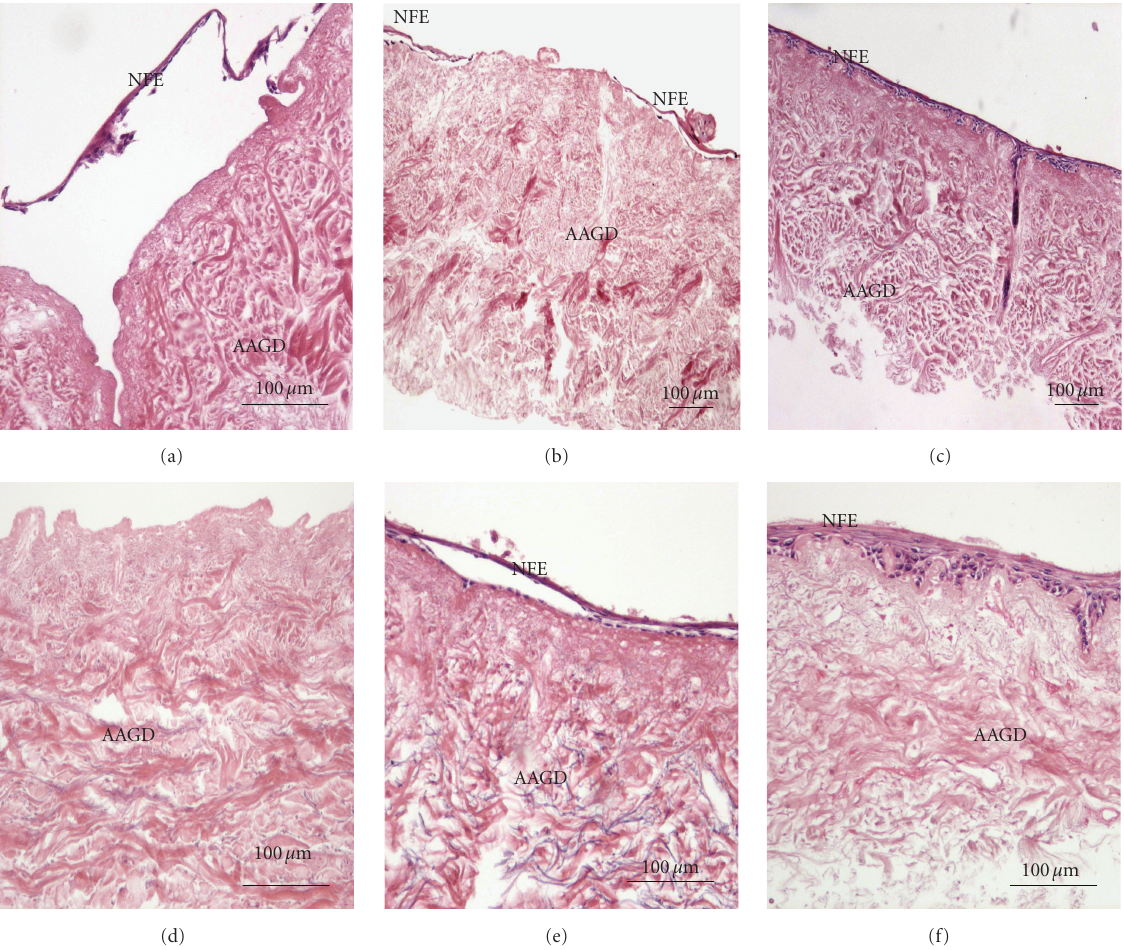
Figure 3: Histomorphological analysis of the dermis obtained by the three di ff erent techniques nebulized with keratinocytes. The sample refers to the 14th day ((a), (b), and (c)) and to the 21st day ((d), (e), and (f)), (a) and (d) Dispase II, (b) and (e) Trypsin, (c) and (f): the manual method. Nebulized cell adherence was observed only in the one prepared manually. Original magnification: 10x ((a), (d), (e) and (f)) 5x ((b) and (c)). AAGD: alloplastic acellular glycerolized dermis; NFE: newly formed